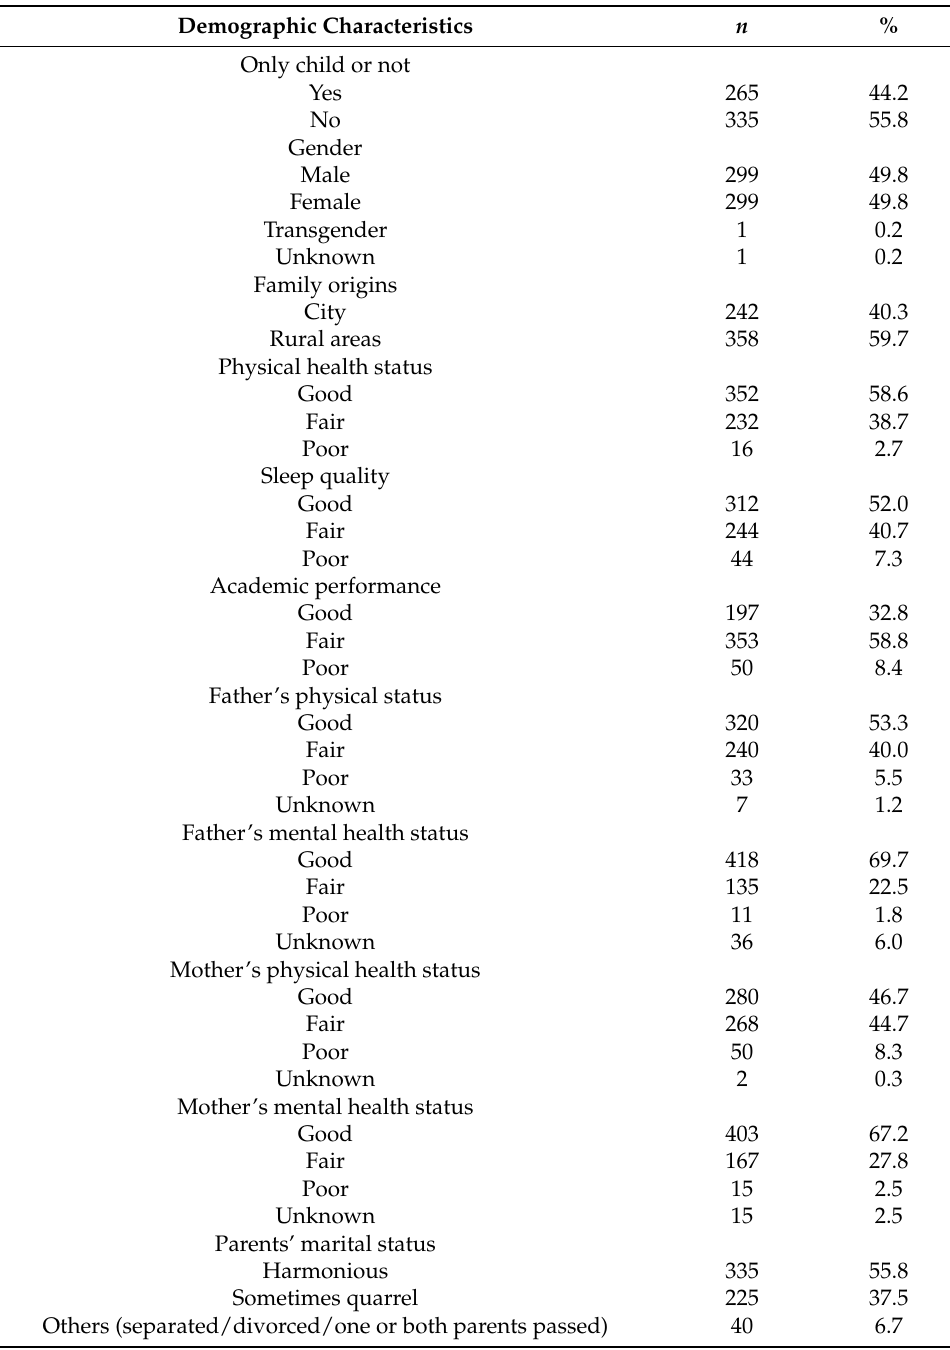
Table 1. Demographic characteristics of sampled college students ( n =